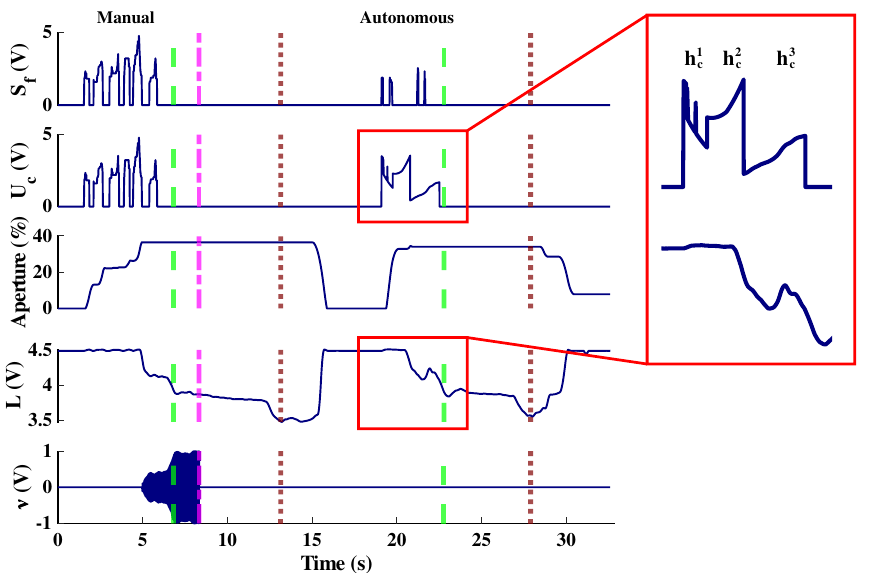
Figure 3. Example signals from the first trial of a participant in the Haptic Shared Control condition as they grasped and lifted the brittle object twice. The green dashed lines indicate when the object was lifted, and the brown dotted lines indicate when the object was set down. The pink dashed lines indicate when the autonomous controller was enabled. The traces shown are sEMG flexion activity S f , closing command u c , the percent closed of the prosthesis, the load cell signal L , and the C-2 tactor vibration signal ν . The traces depict two successful grasp-and-lifts, where the first attempt was done manually with vibrotactile feedback, while the second attempt was completed using the autonomous control. Note that it is possible to identify the three stages of autonomous 1 h 2 h 3 control (first is h c , the decaying command, second is c , the ramping up command, and third is c , the proportional integral controller